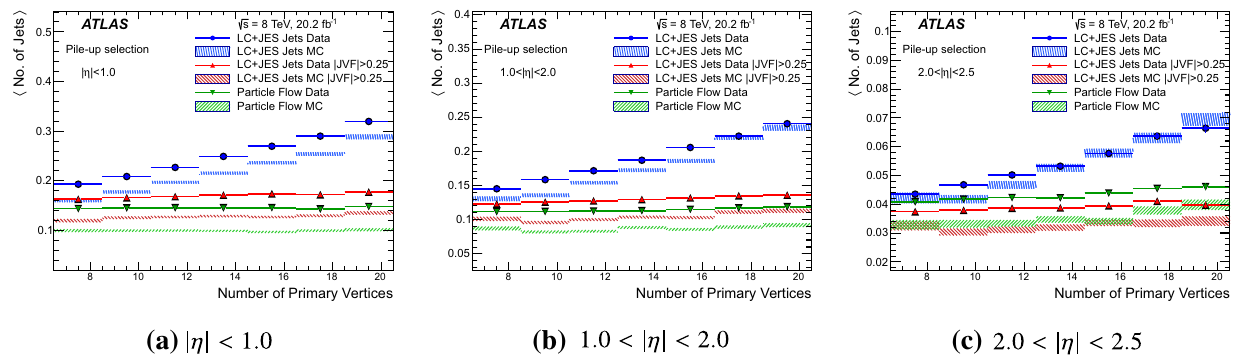
Fig. 32 The average number of jets per event, for jets with p T > 20GeV, as a function of the number of primary vertices in the Z → μμ samples. The distributions are shown in three different | η | regions for particleflowjets,calorimeterjetsandcalorimeterjetswithanadditional